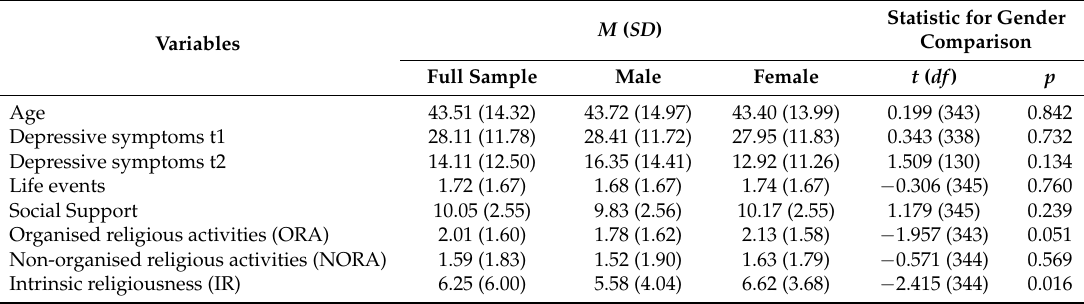
Table 1. Demographic characteristics of the